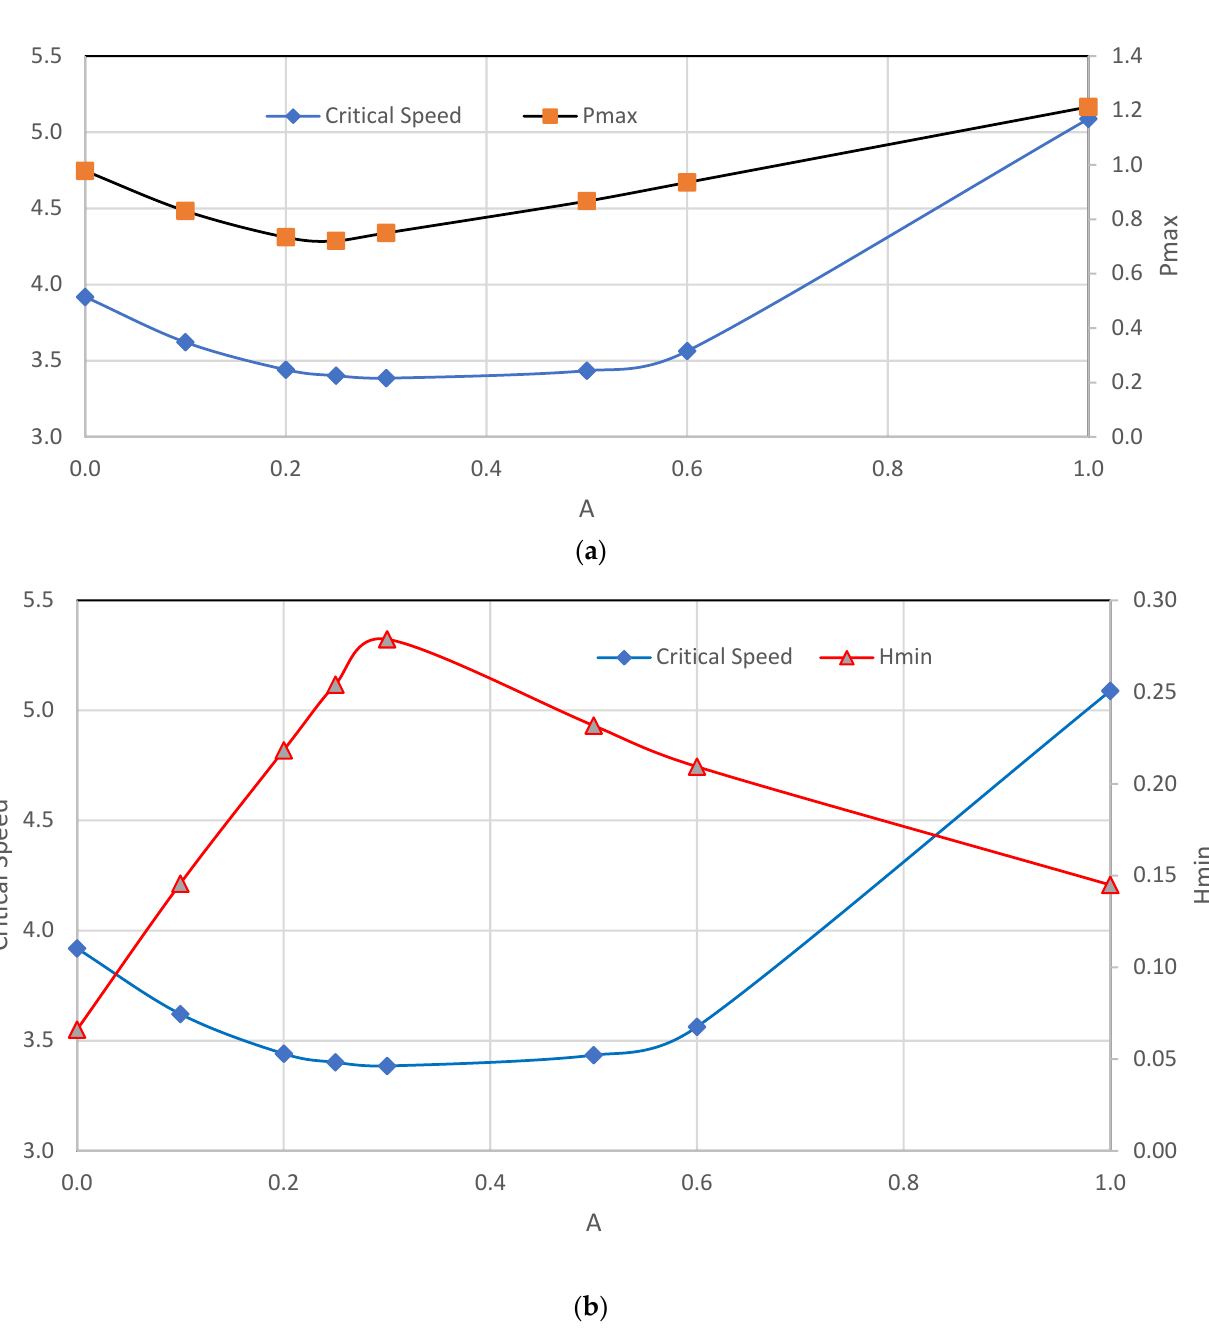
Figure 7. Effect of chamfer parameter A on the dimensionless ( a ) critical speed and Pmax and ( b ) critical speed and Hmin. (B = 0.25, L/D = 1.25, ∆ℎ 𝑜 = ∆𝑣 𝑜 = 0.58, and 𝜀 𝑟 = 0.6 ).